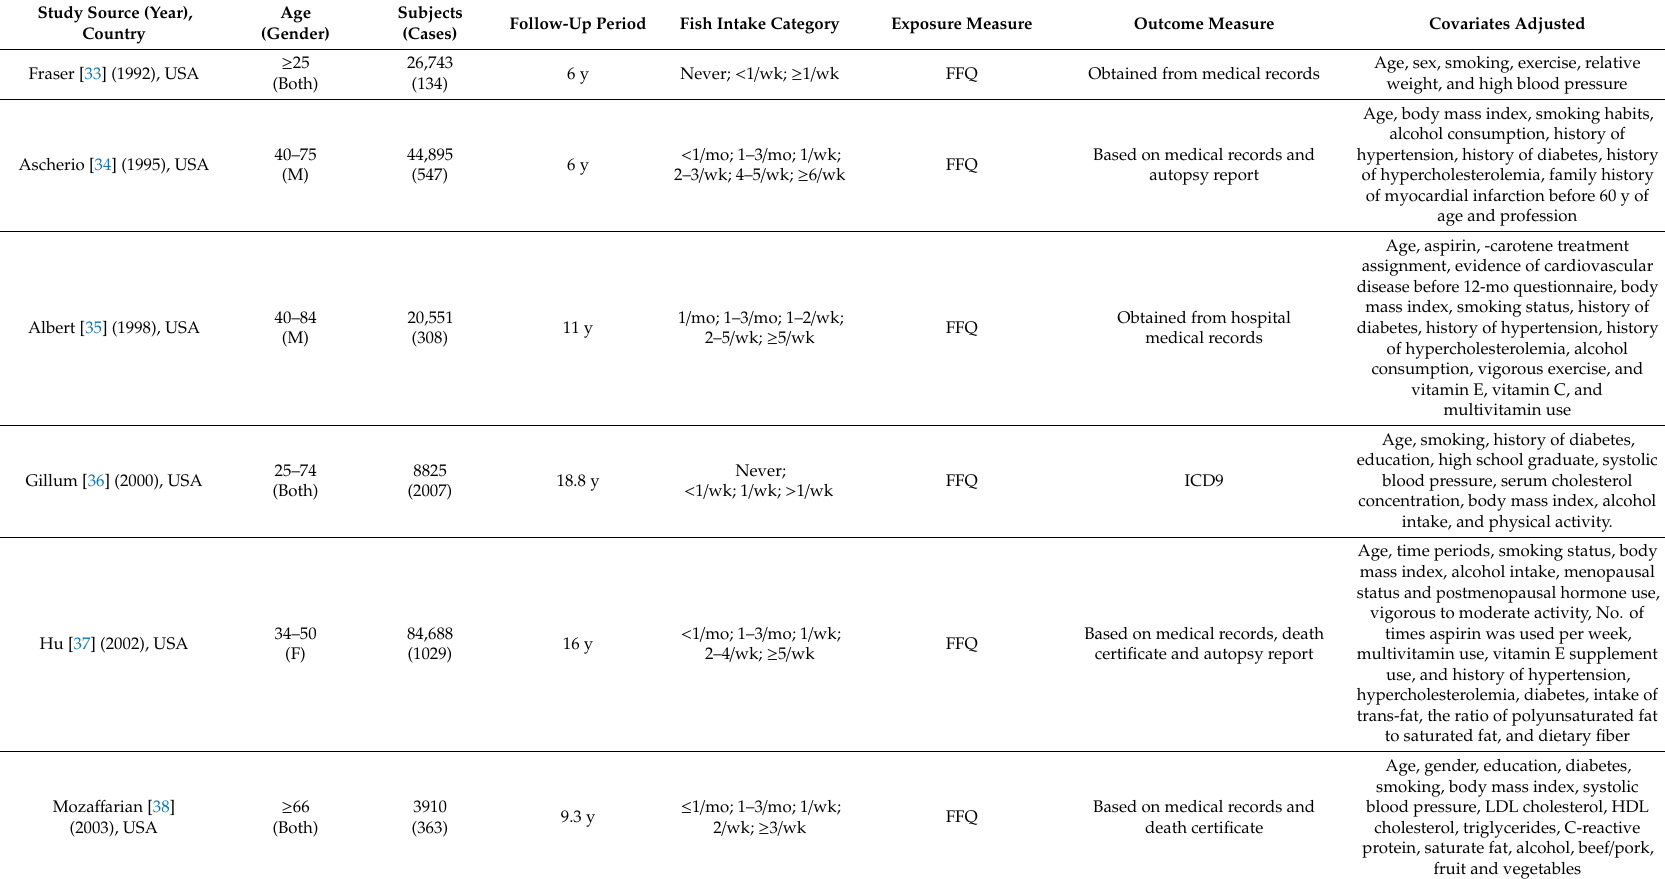
Table 1. Characteristics of cohort studies included in the meta-analysis of fish consumption and coronary heart disease (CHD) incidence. Study Source (Year), Country Fraser [33] (1992),